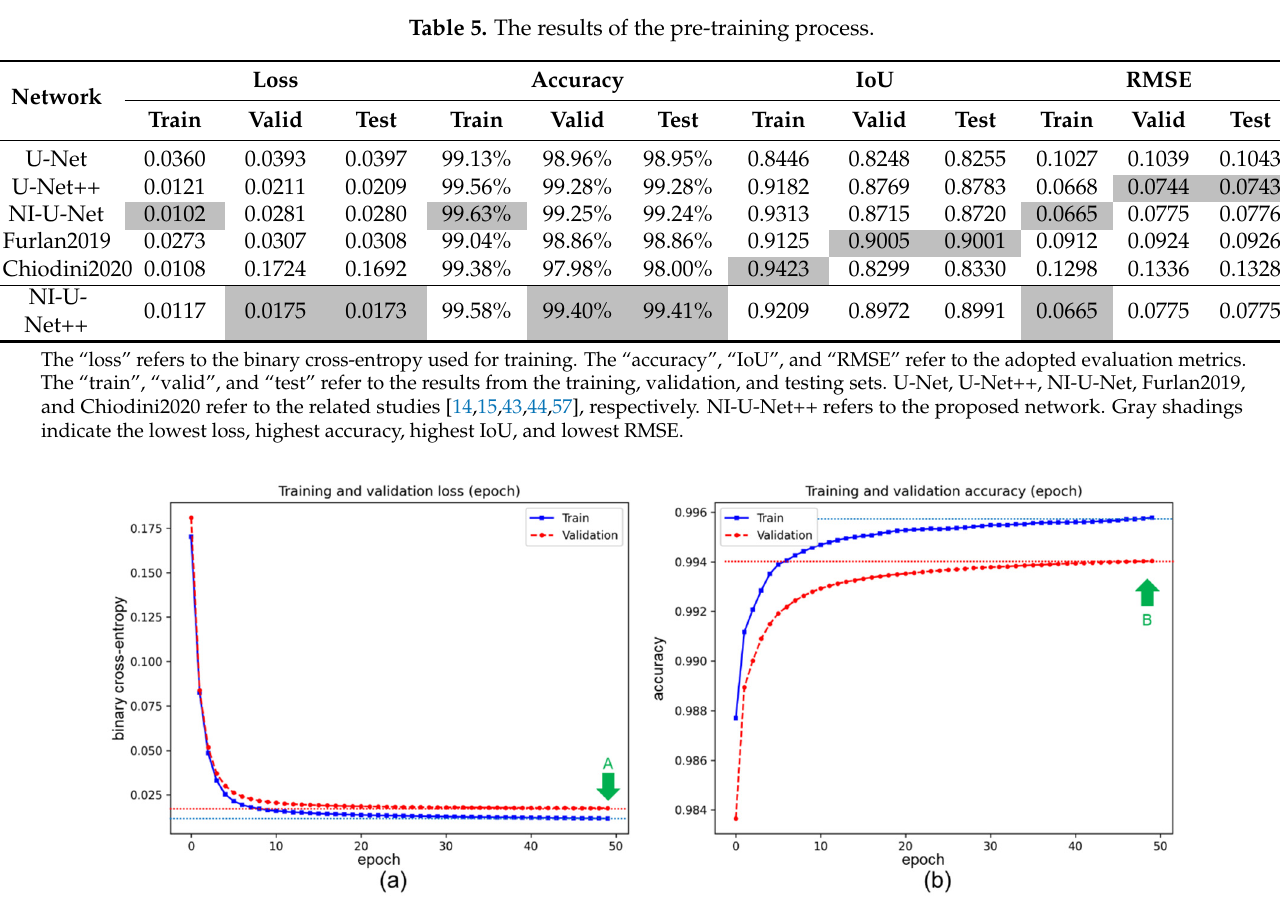
Figure 7. The loss and accuracy curves of NI-U-Net++ using the synthetic dataset. The green “A” and “B” correspond to the two highlights mentioned in the content of the NI-U-Net++ curves. ( a ) refers to the epoch-wised loss curves in the training and validation sets. ( b ) refers to the epoch-wised accuracy curves in the training and validation sets. The horizontal dash lines refer to the references of final converge status.